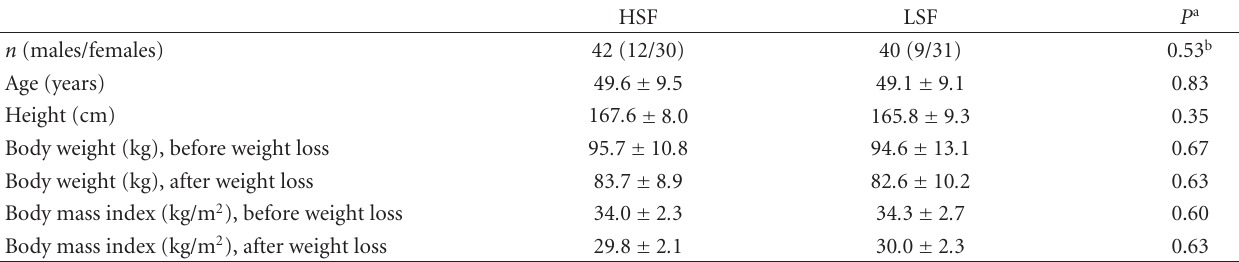
Table 4: Subjects in the higher-satiety food (HSF) and lower-satiety food (LSF) groups. Mean ± SD. HSF LSF P a